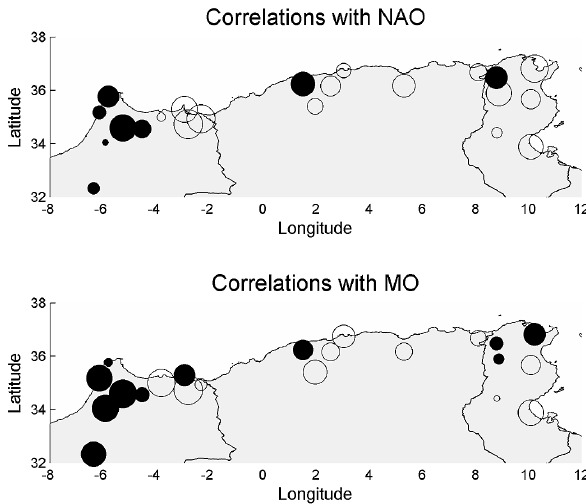
Fig. 10. Correlation between annual precipitation (PRCPTOT) and the NAOi and MOi indices at the different stations. The size of the circles is proportional to the Spearman correlation coefficients. The circles filled with black are the stations where the correlation is sig- nificant at the 5%